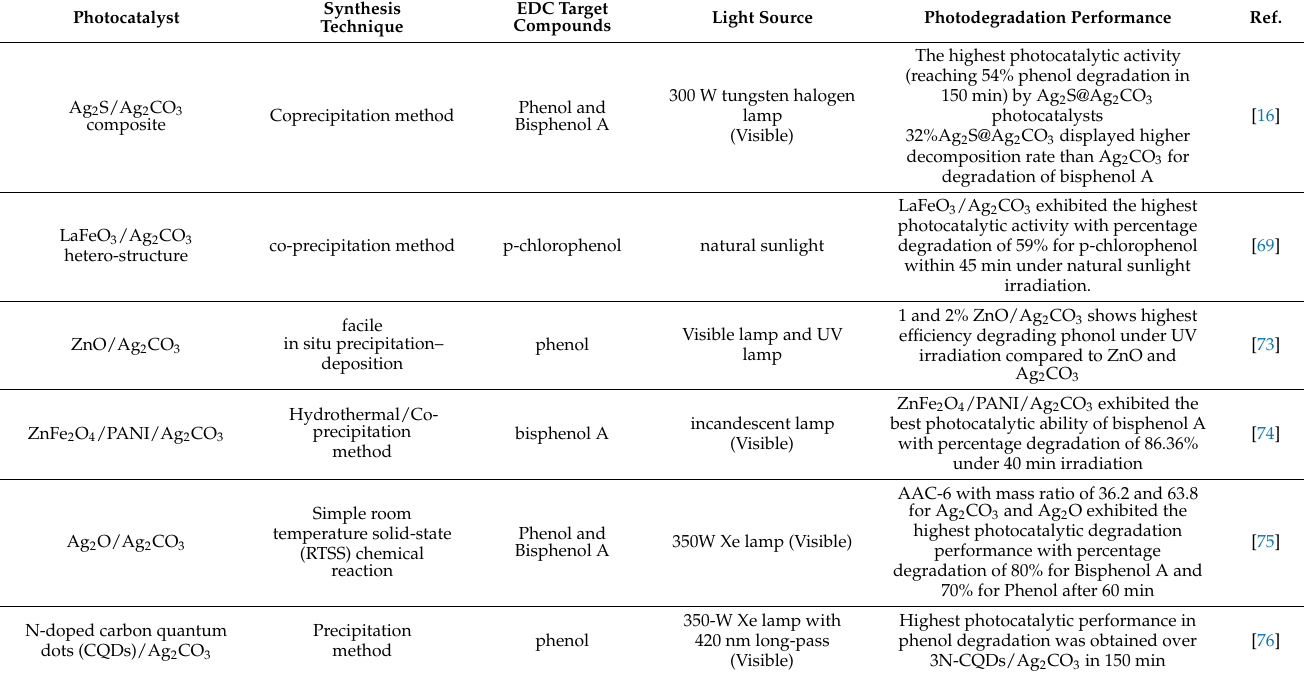
Table 3. Photocatalytic degradation of EDCs by Ag 2 CO 3 -based photocatalysts prepared by various experimental